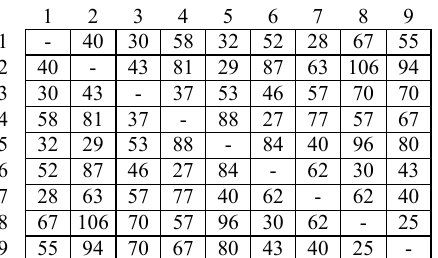
Korak 4: kada je lista u{teda potro- {ena do kraja treba zavr{iti algoritmom. Primena algoritma „u{teda“ prikazana je na primeru transportne mre`e sa slike 2. Tro{kovi transporta, u nov~anim je- datoj transportnoj mre`i prikazani su u tabeli